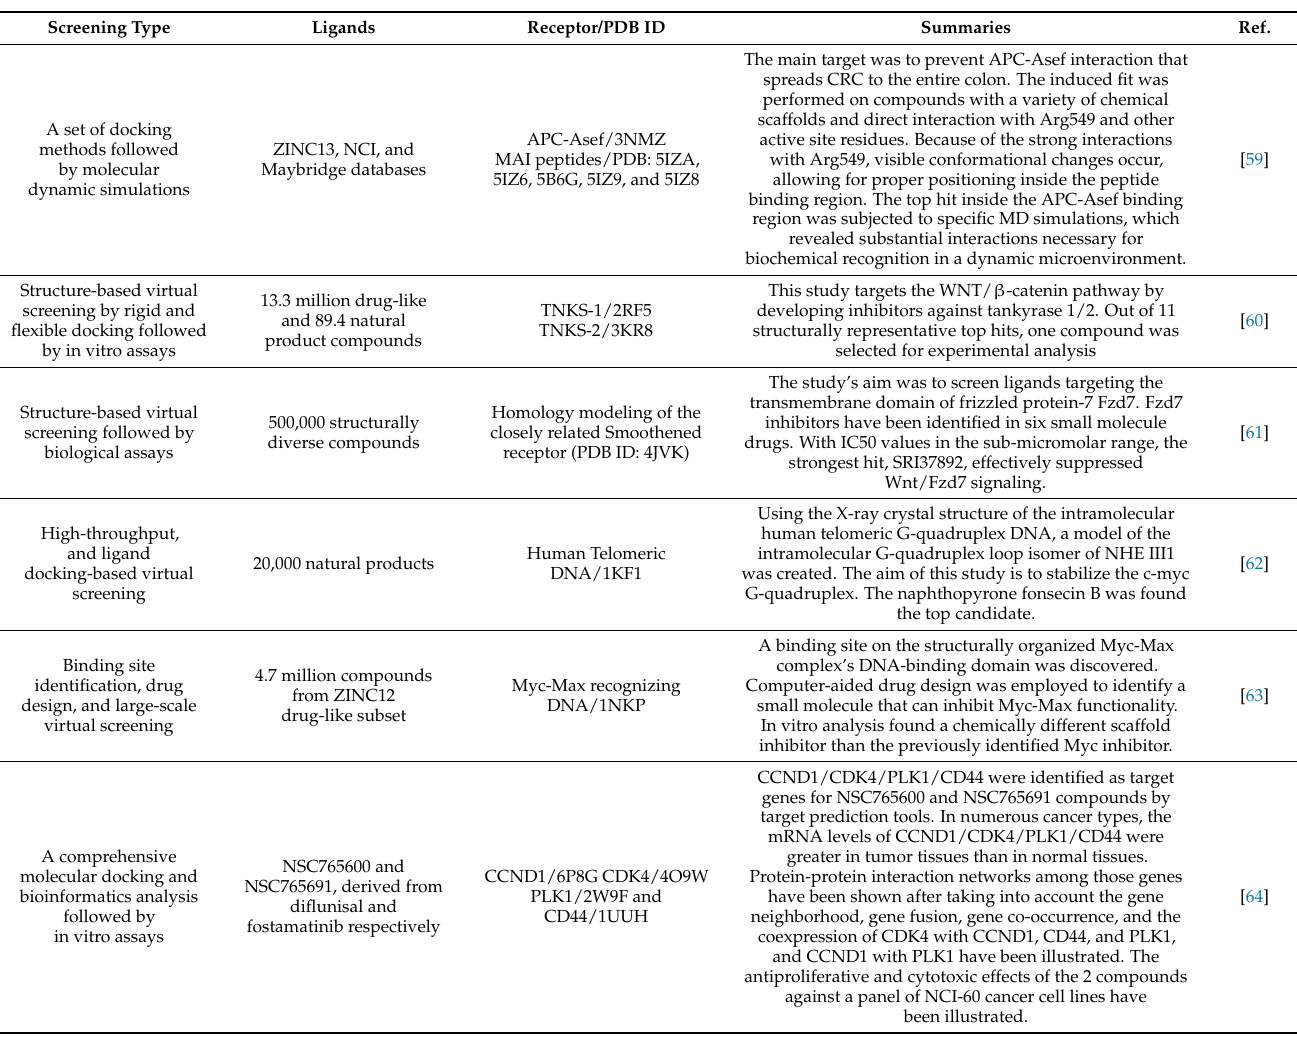
Table 1. In silico screening studies that tackle tumor suppressor genes with a library of compounds used and the summaries of those